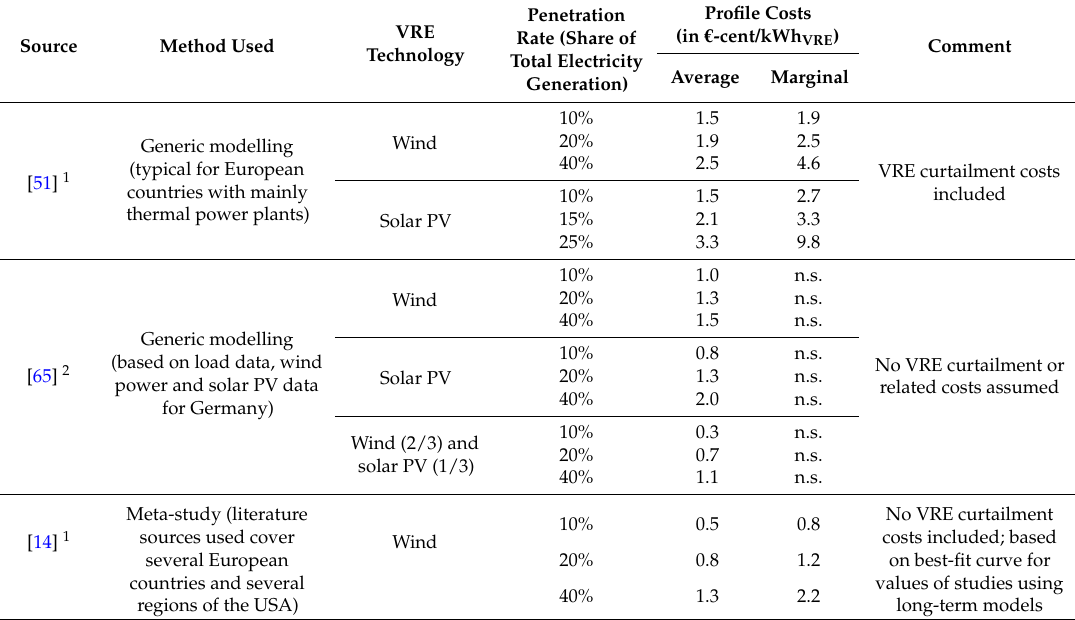
Table 4. Average and marginal specific profile costs from wind and solar PV electricity generation according to several